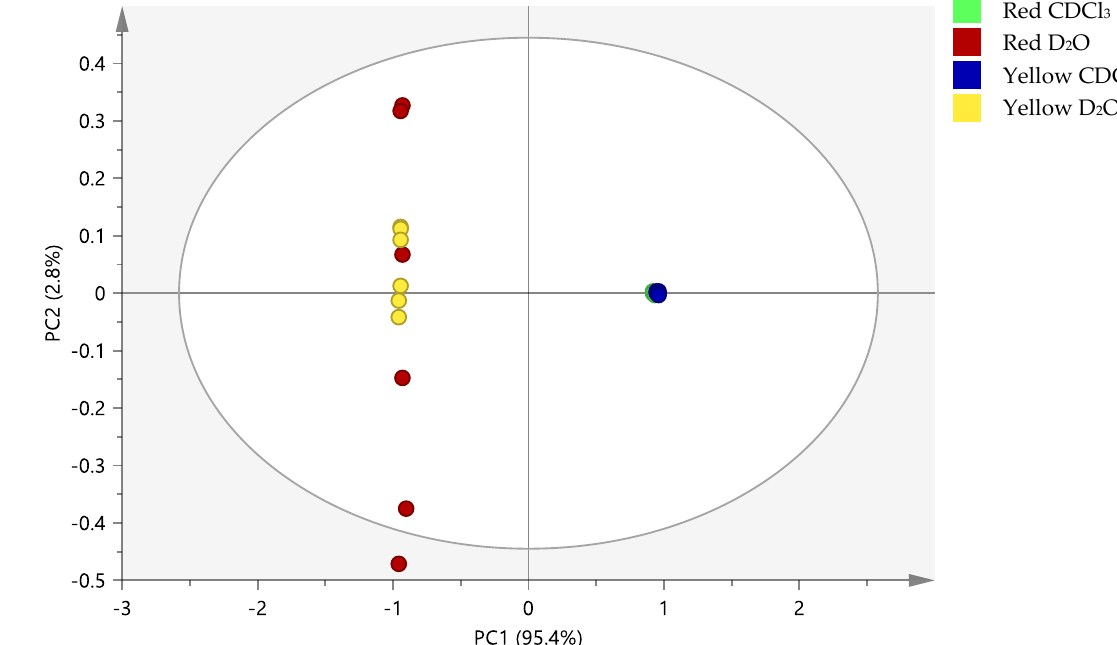
Figure 3. The principal component analysis (PCA) score plot of the 1 H-NMR data representing red and yellow watermelon cultivars in two different solvents (D 2 O and CDCl 3 ); R2X = 0.991, Q2X = 0.983, n = 6.